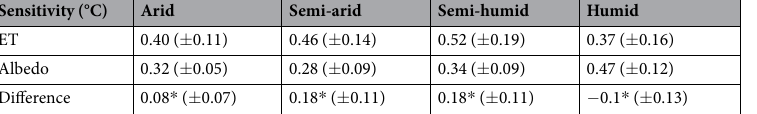
Table 1. The sensitivity (mean ± standard deviation) of evapotranspiration (ET)/albedo to NDVI changes (every 0.1 increment). “ * ”indicates a significant difference at the confidence level of p <